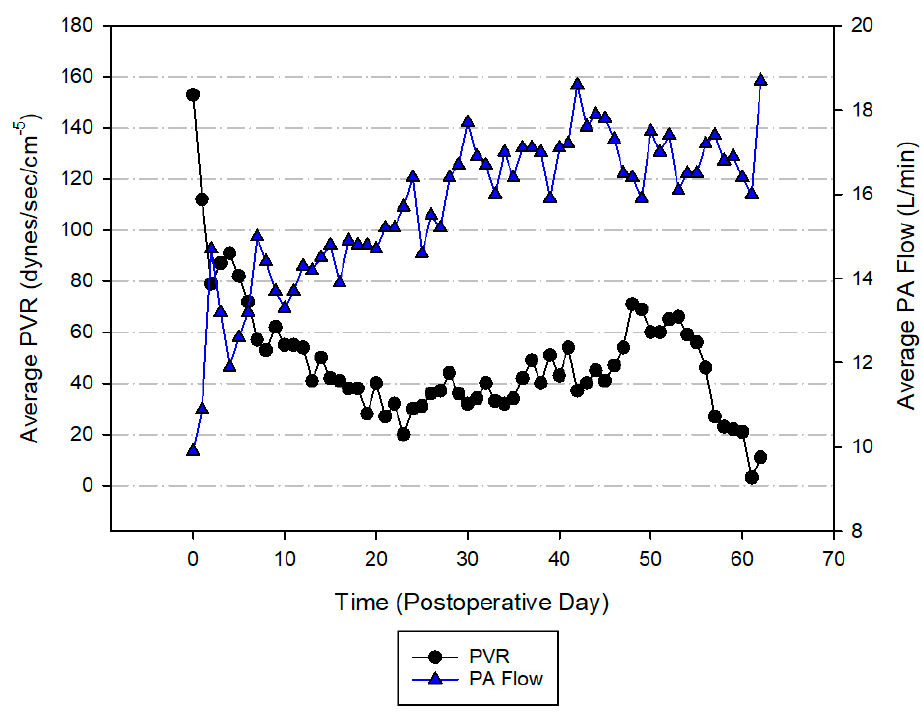
Figure 3. Daily average for hourly pulmonary vascular resistance (PVR) and blood flow through the pulmonary artery (PA).